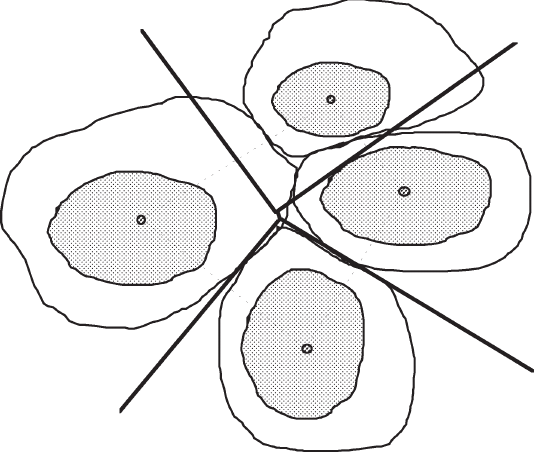
Fig. 1. Given a series of points, Voronoi polygons are constructed by drawing the bisectors of the lines joining each pair of adjacent points in a plane. The example shown here for four cells, illustrates how Voronoi polygons constructed based upon the centroids of cell nuclei can be used as an approximation of cellular boundaries. The bisectors, however, do not directly correspond to cell–cell